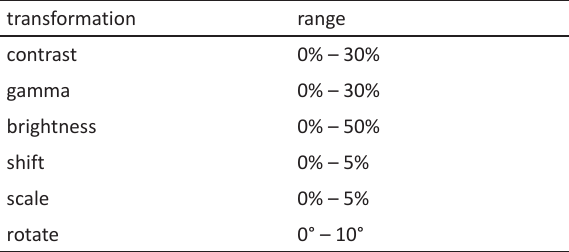
Table 2. Training set augmentation transformations and